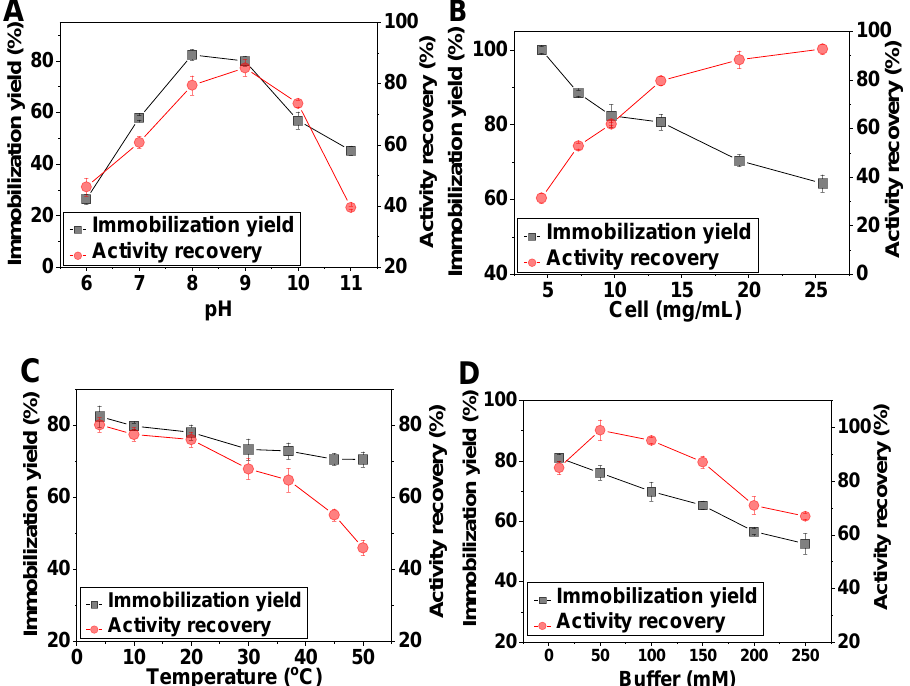
Figure 3. Effect of (A) pH, (B) cell concentration, (C) temperature, and (D) buffer concentration on the immobilization of E. coli cells. All the experiments were repeated three times, and the standard deviation was calculated and presented.